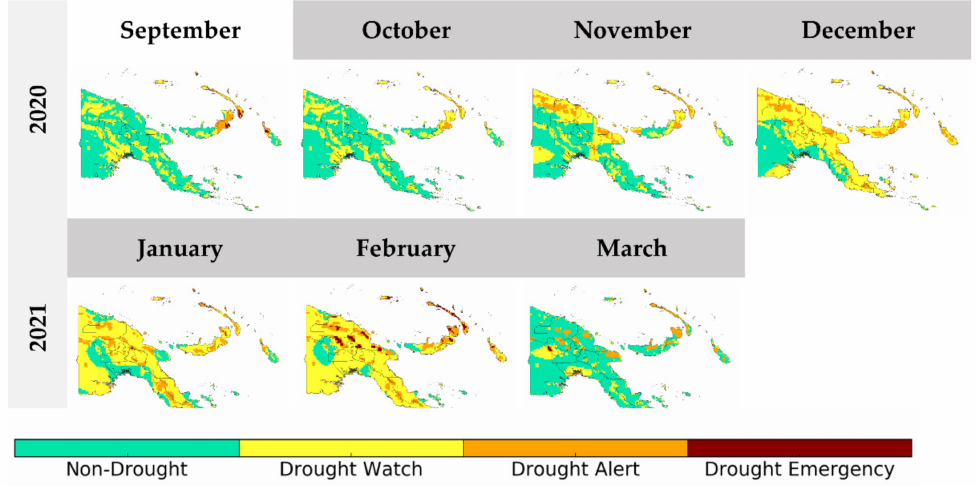
Figure 16. Drought I-EWS evolution of the 2020 La Niña-induced dry period in PNG. Dark grey bar indicates months when the La Niña was active as declared by the Bureau of Meteorology